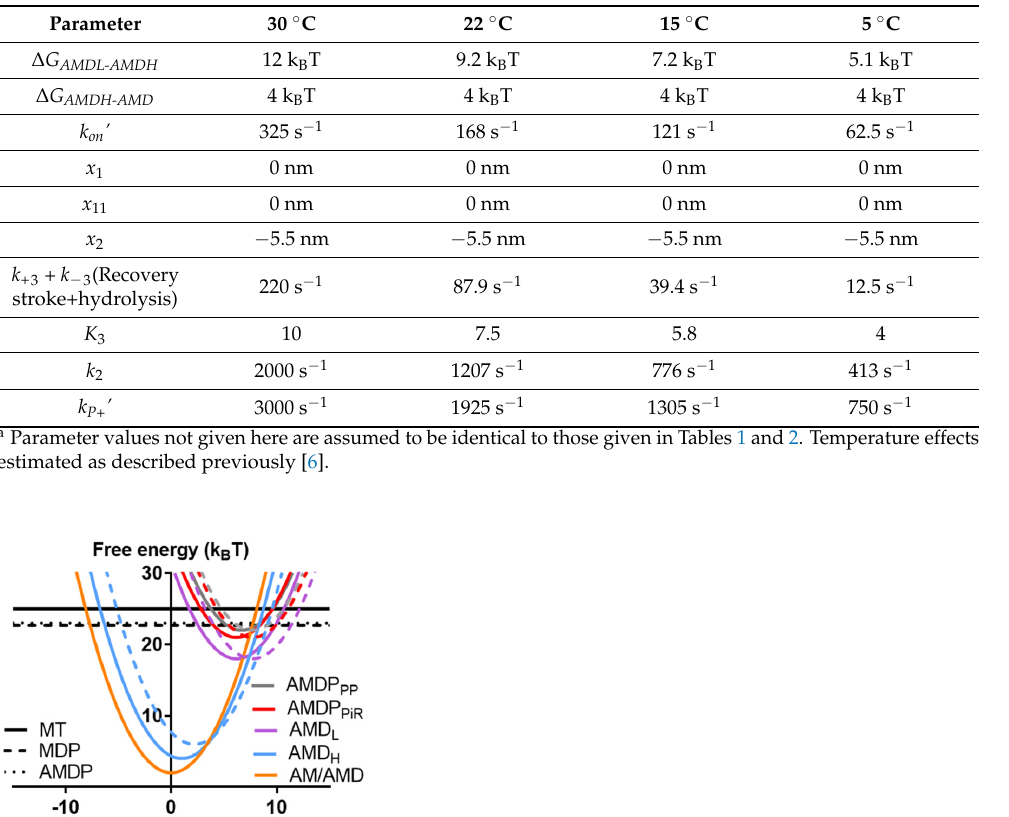
Table 3. New parameter values for parameters modified to final optimized model and effects of temperature on these and other parameter values a .